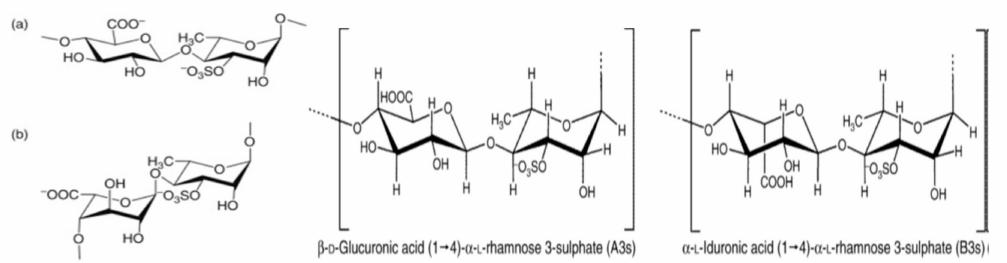
Figure 4. Structure of ulvanobiuronic acid units, ( a ) β -D-glucuronosyluronic acid-(1,4)- α -L-rhamnose 3-sulfate and ( b ) α -iduronopyranosic acid-(1,4)- α -L-rhamnose 3-sulfate [121,137]. Other components of green macroalgae cell walls are xylan, mannan, and